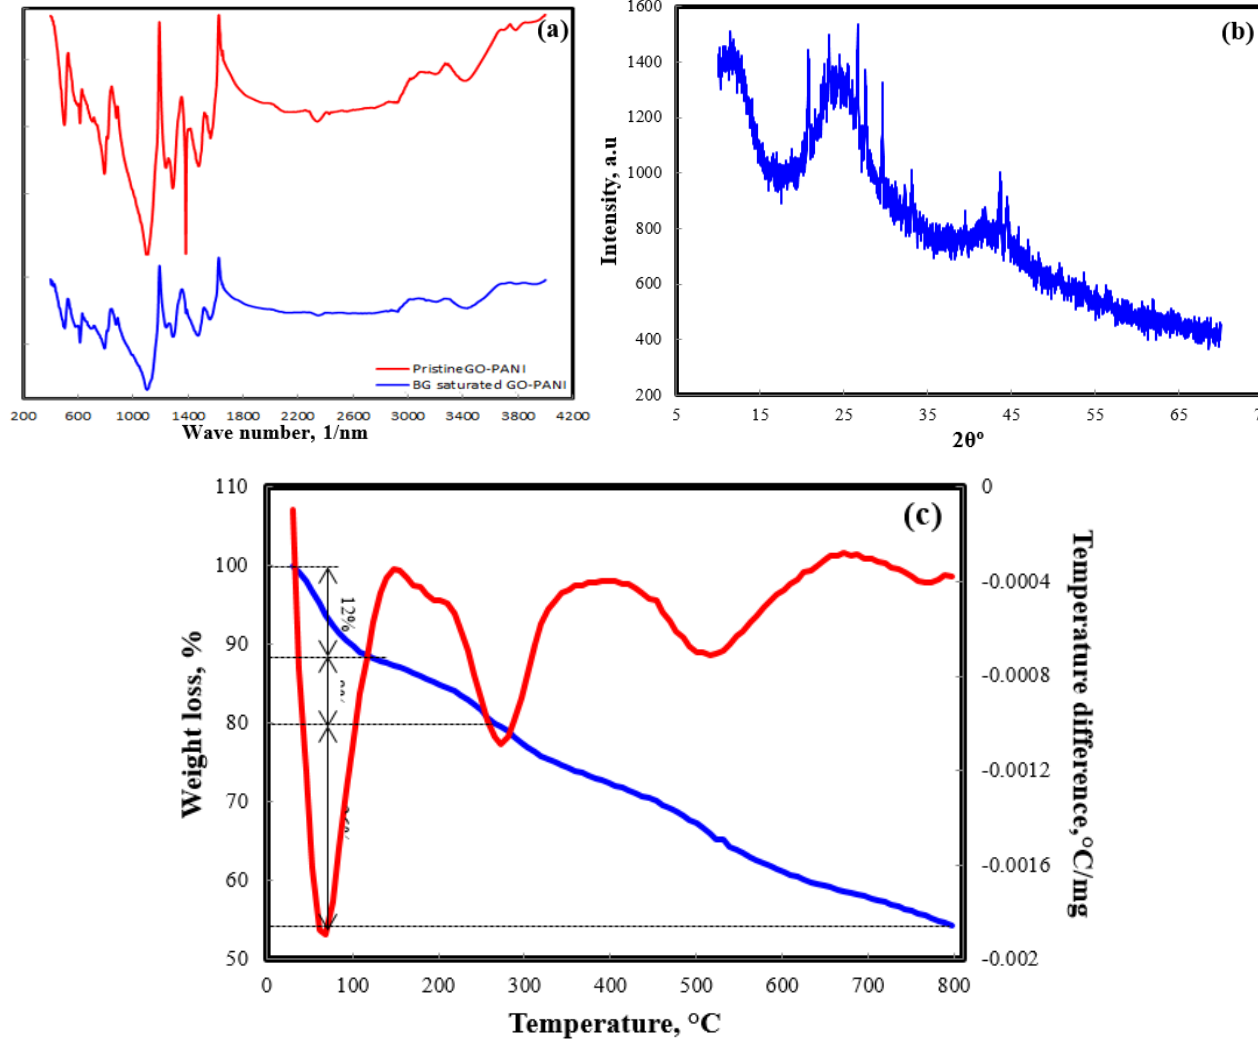
Figure 1. FT-IR ( a ), XRD ( b ), and TGA-DTA ( c ) plots of graphene oxide–polyaniline (GO-PANI). Morphologically, the GO-PANI surface, due to the deposition of PANI nanofibers over GO nanosheets, was rough and uneven (Figure 2a). The edges extended in rod like particles, signifying that PANI was successfully grafted on the edges of the GO sheets.